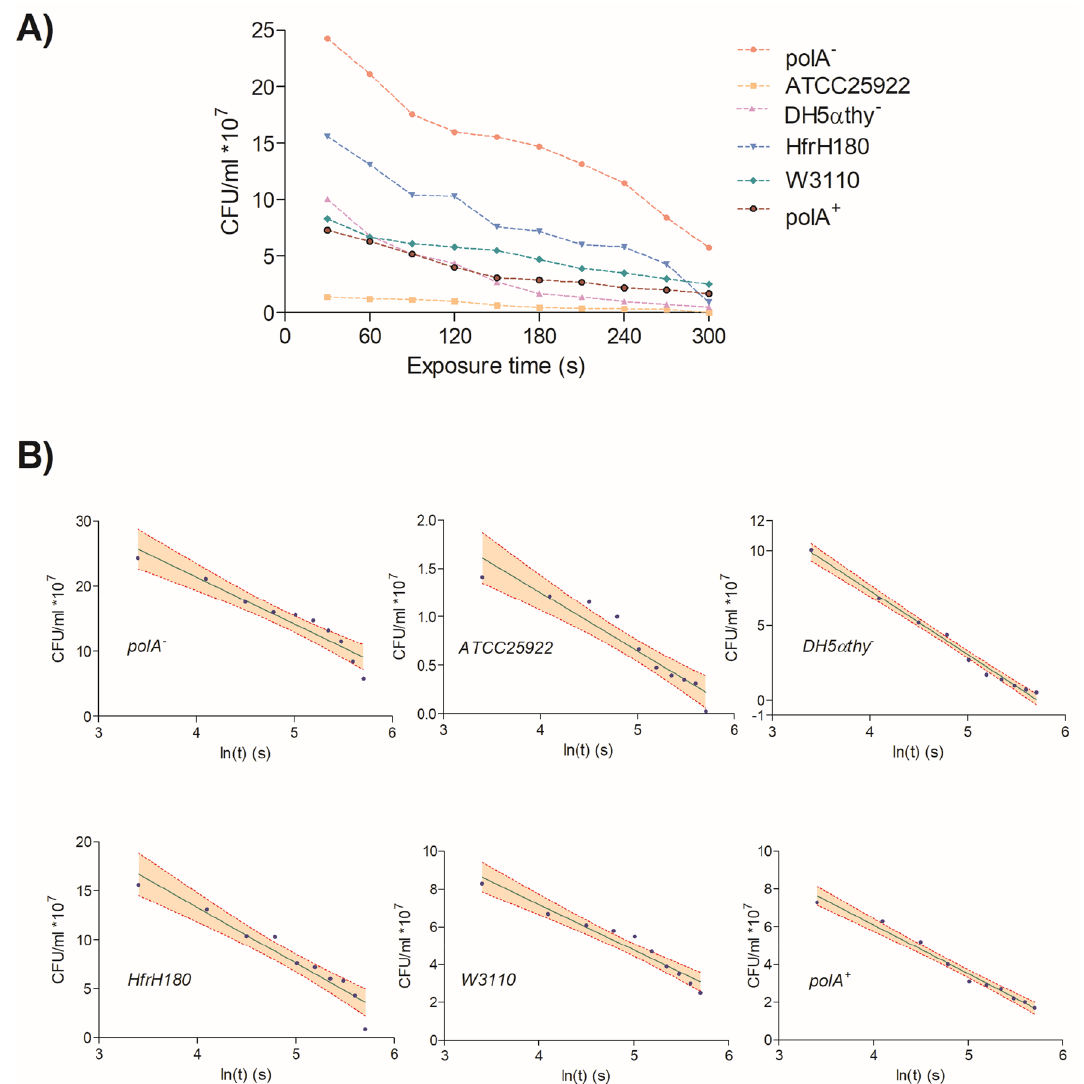
Figure 3. Survival curves of E coli strains. ( a ) Representation of survival of all used strains. ( b ) Dispersion plots with fiduciary limits (red lines) and confidence intervals (fawn colored